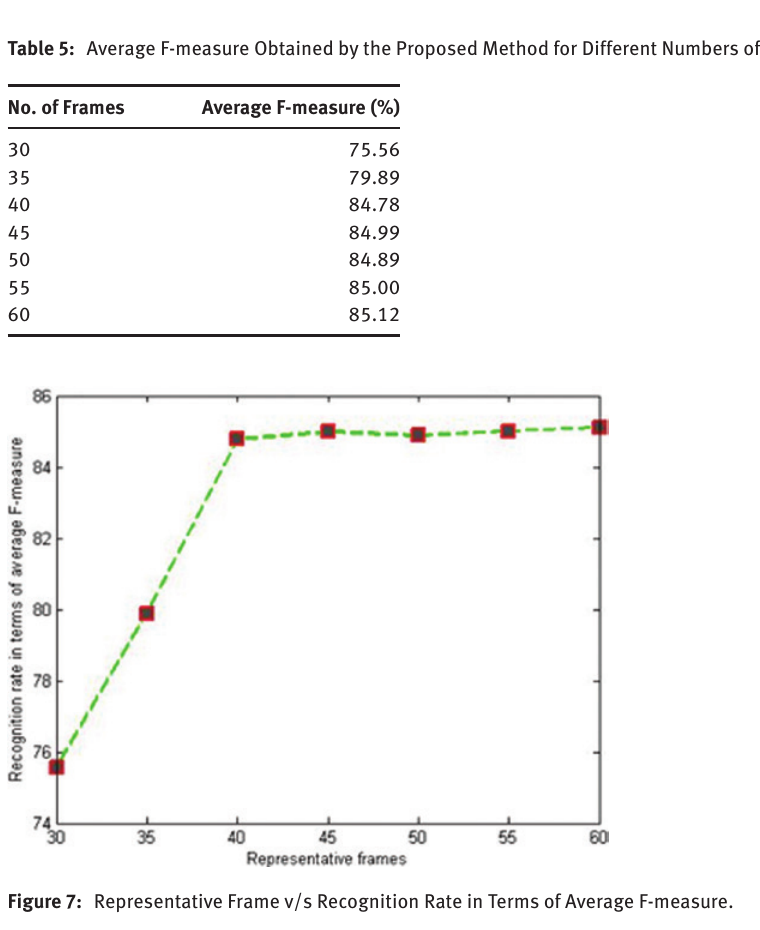
Figure 7: Representative Frame v/s Recognition Rate in Terms of Average F-measure.